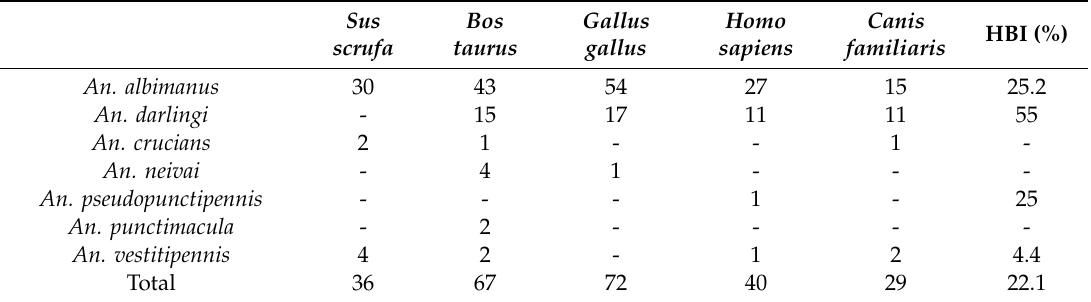
Table 2. Blood meal origins and Human Blood Index (HBI) in seven Anopheles species.